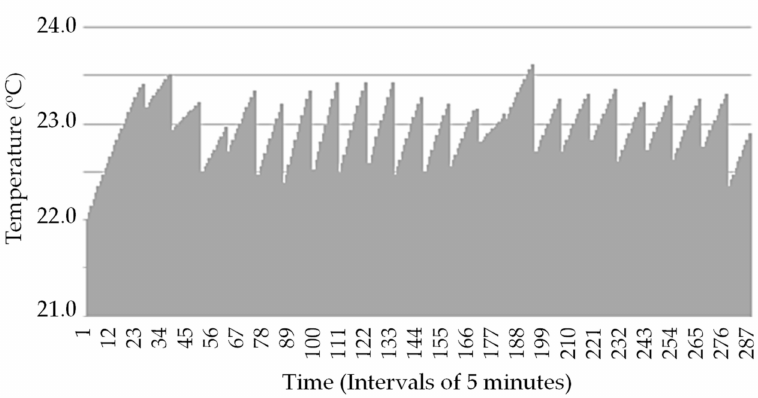
Figure 9. Evolution of the environmental temperature in the smart house, during the day, considering the critical peak pricing scheme.